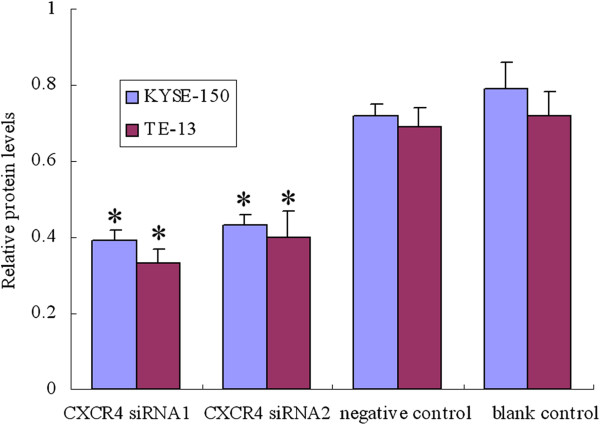
CXCR4 siRNA inhibited significantly the protein expression of CXCR4. Cells were incubated with different synthetic oligonucleotides as described in the materials and methods section, and CXCR4 protein was quantified by Western-Blot. The targeted CXCR4 siRNA inhibited significantly the protein expression of CXCR4 gene (*p <0.05).